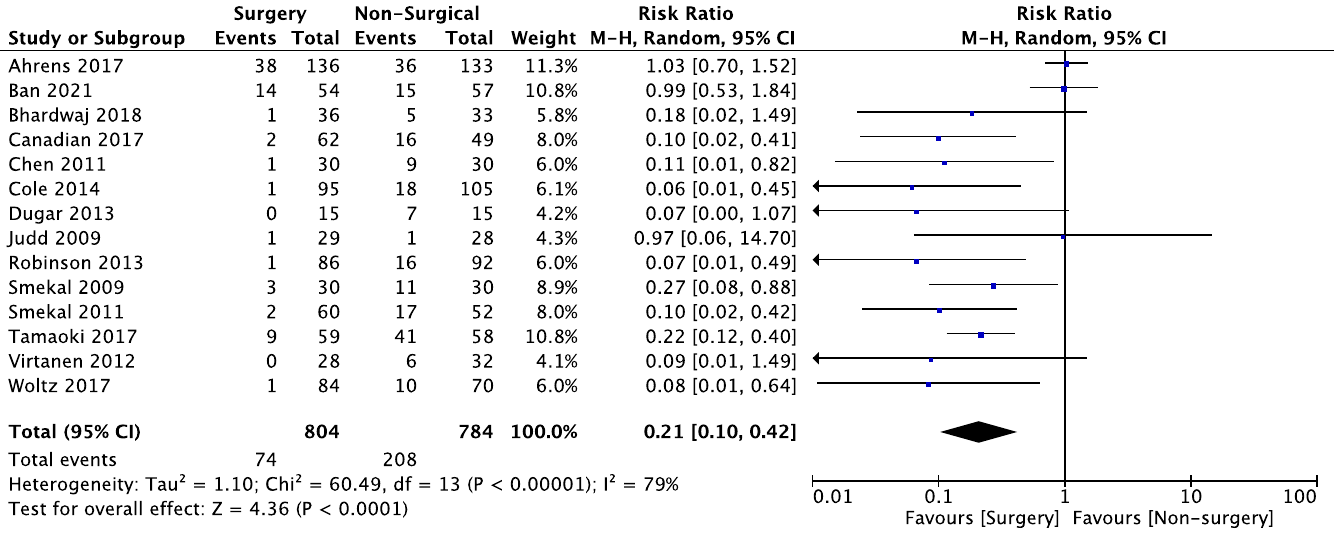
Fig 7. Meta-analysis of risk ratio of bone-related major complications (including bone non-union, malunion, implant failure) between surgical and non-surgical intervention in pooled studies. The risk ratio is 0.21 (95% CI 0.10 to 0.42; p < 0.001).